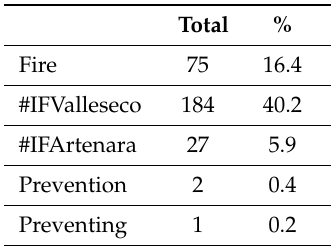
Table 4. Tweets by words. Source: own